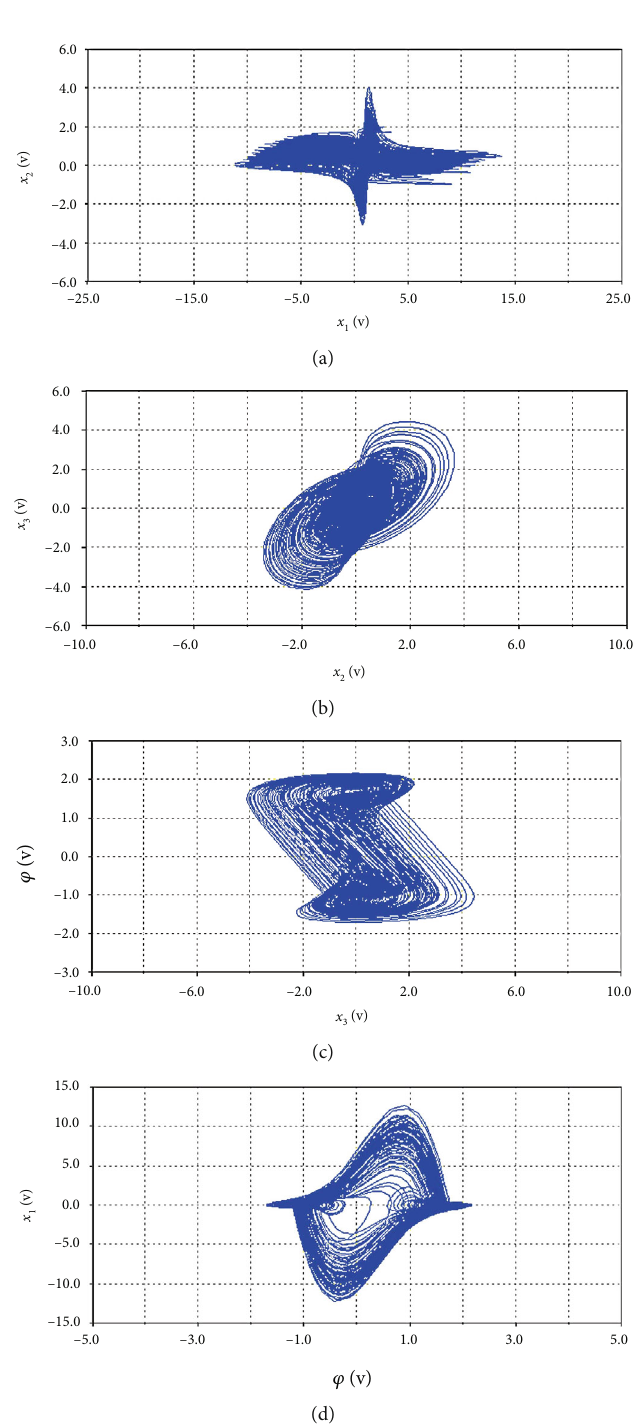
‐ x x ‐ x x ‐ φ phase diagram, and (d) φ ‐ x 1 2 phase diagram, (b) 2 3 phase diagram, (c) 3 1 phase